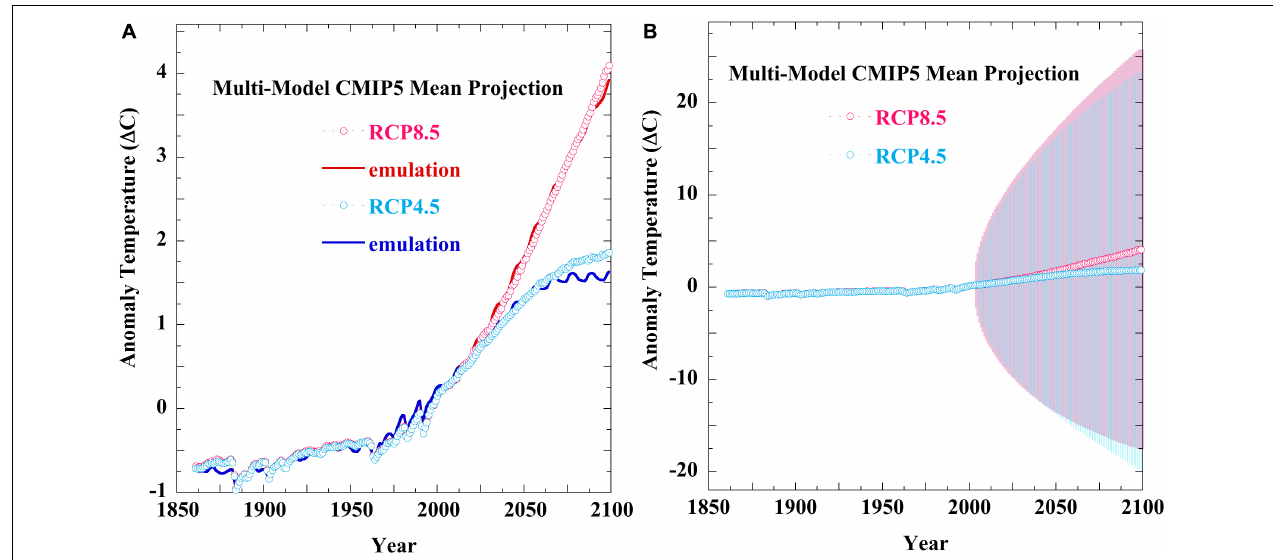
FIGURE 7 | Panel (A) (points), the CMIP5 multi-model mean anomaly projections of the 5AR RCP4.5 (o, 21 models) and RCP8.5 (o, 21 models); (full lines), the equation 1 emulations of the CMIP5 mean projections. The standard RCP forcings including solar and 25% volcanic forcing were used throughout (Meinshausen et al., 2011). Individual CMIP5 mean forcings may not be identical to the Meinhausen RCP forcings. Panel (B) : (colored lines), the same two CMIP5 mean RCP projections with uncertainty envelopes derived from propagating the annual average ± 4 Wm − 2 CMIP5 long wave cloud forcing error as in equations 5 and equation 6, starting from projection year 2005. For RCP4.5, the emulation departs from the mean near projection year 2050 when GHG forcing becomes constant.